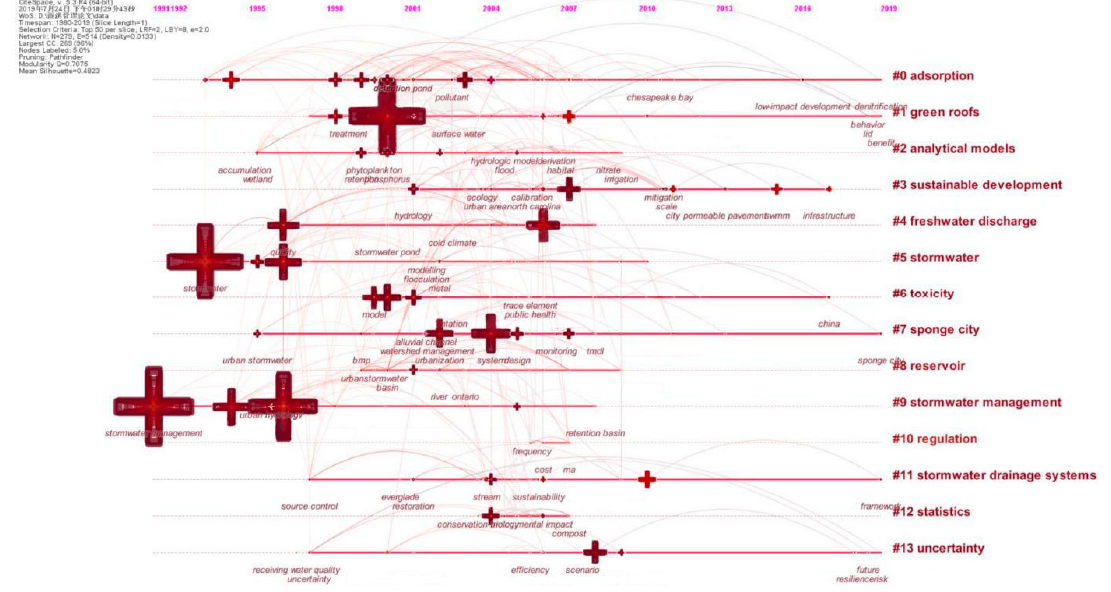
Figure 6. Time zone chart of keywords.